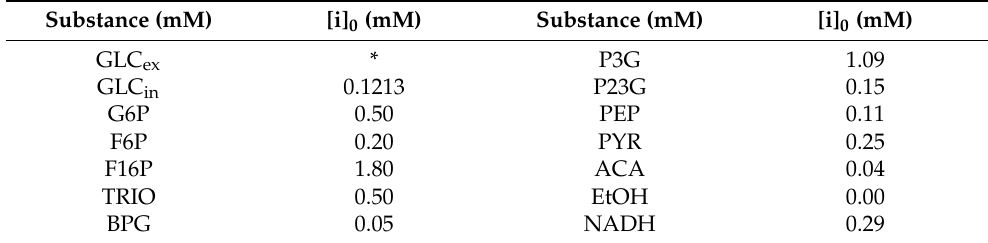
Table 2. Initial concentrations of the substrate, [ i ] , product, and internal metabolites from alcoholic 0 fermentation. Source: van Eunen et al. [16]; Sato et al. [18]; Teusink et al. [17]; Ruoff et al. [19];